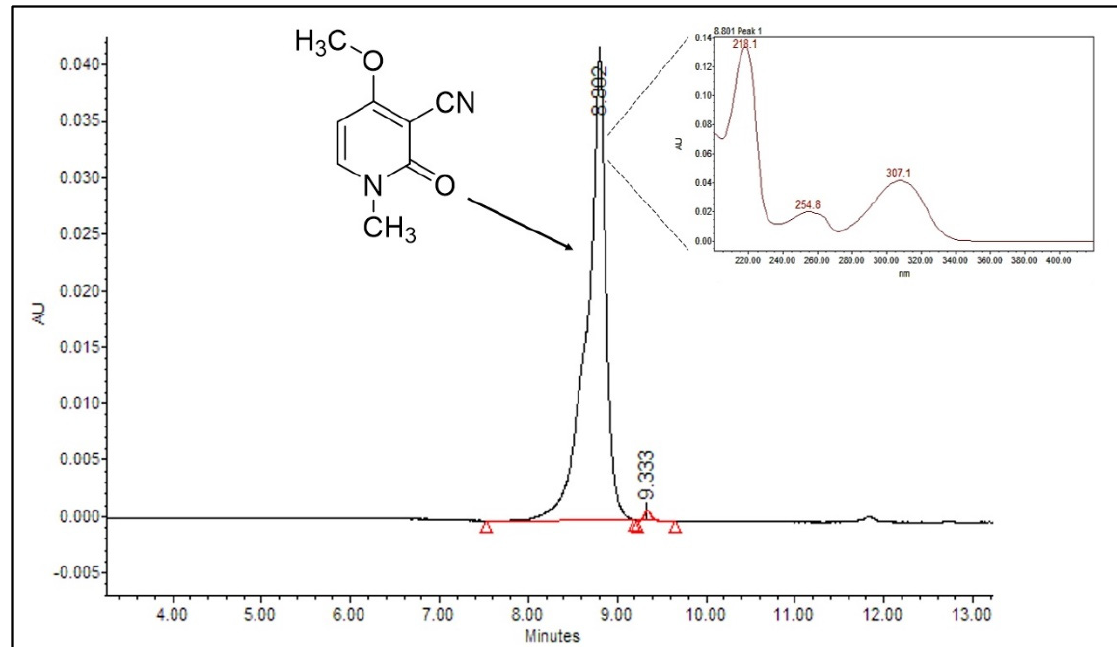
Figure 1. Chromatogram of ricinine standard and its absorption spectrum in UV–Vis. Table 3. Ricinine concentration and area under the curve of ricinine